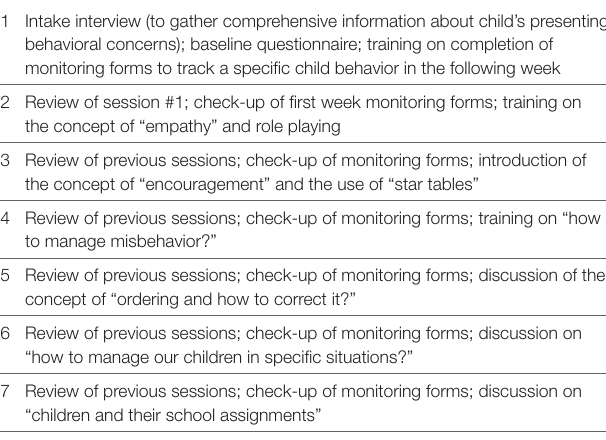
TaBle 1 | Brief report of parent management training